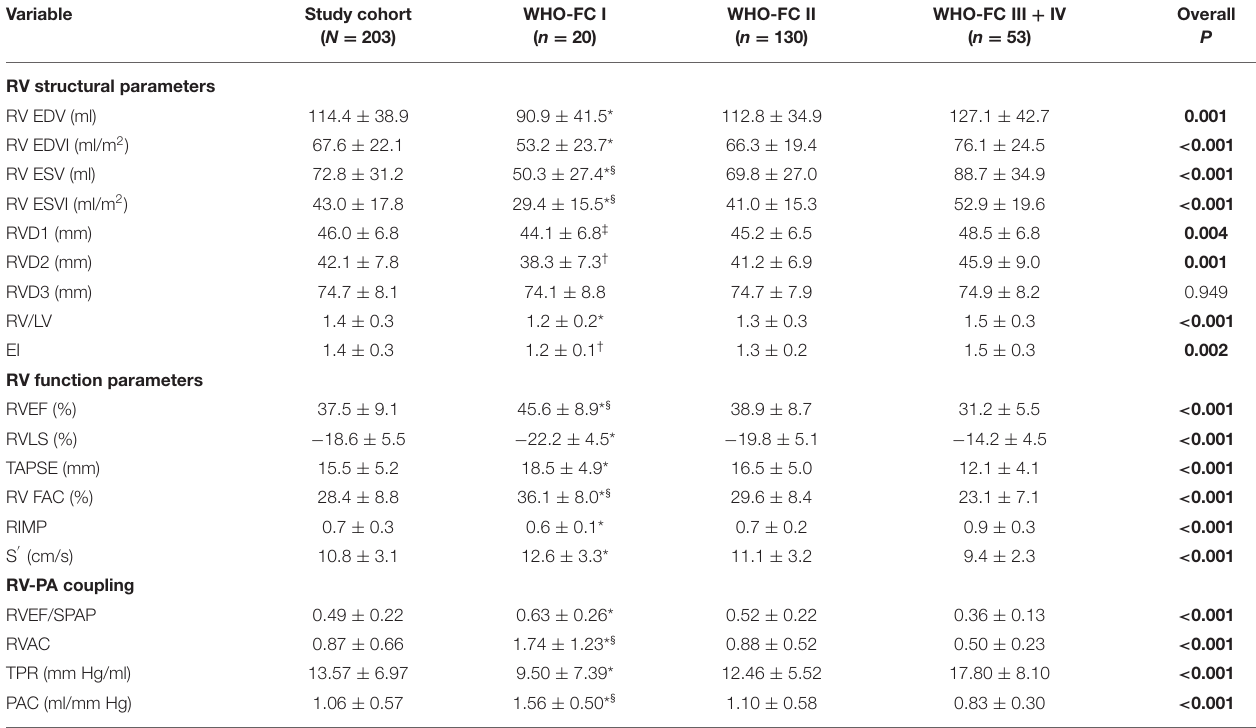
TABLE 2 | Comparison of RV structural parameters and functional indices and RV coupling to pulmonary circulation among groups with differing WHO-FC. Variable